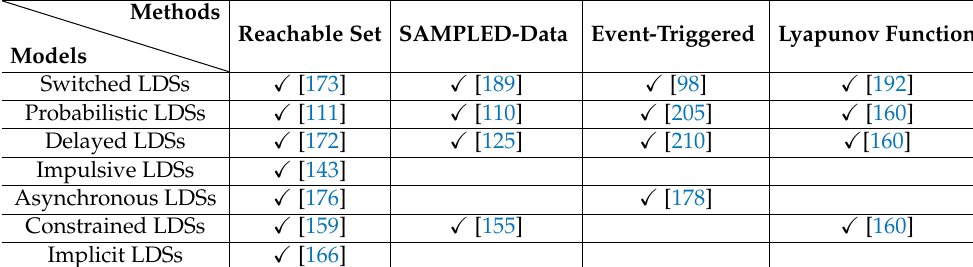
Table 1. A classification for the considered models and methods.